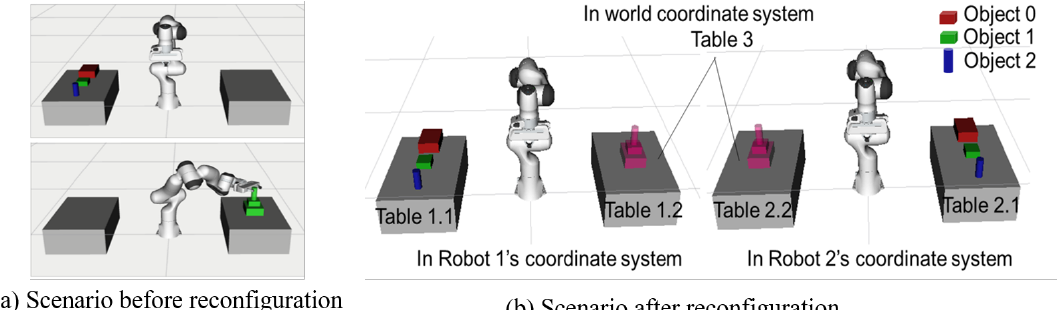
Figure 3. Scenarios of robot assembly